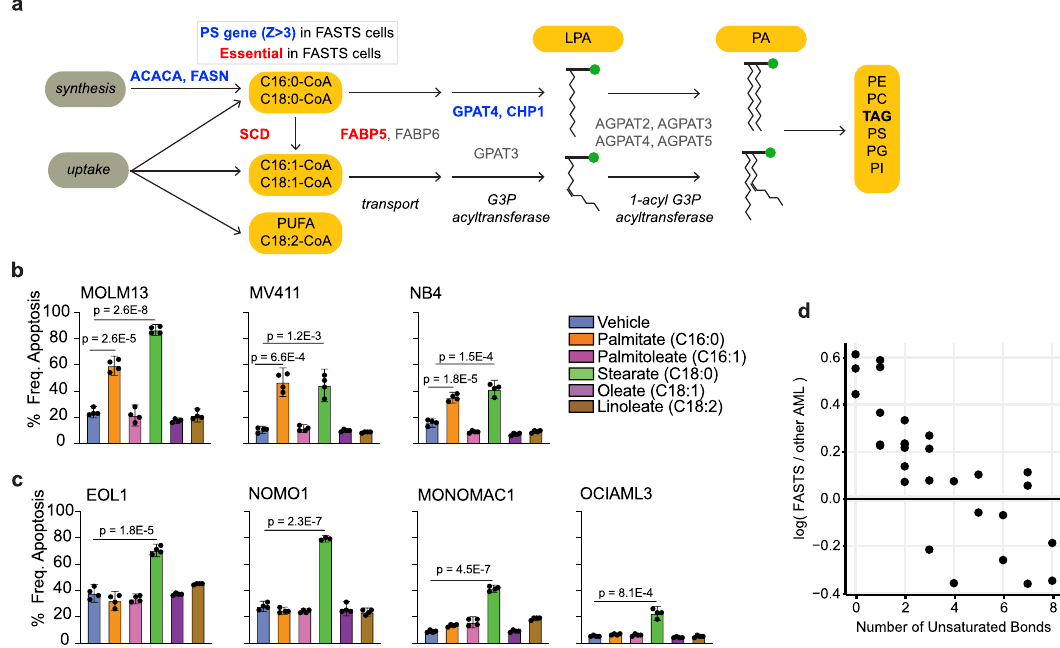
Fig. 5 FASTS cells are sensitive to saturated FA. a Schematic of the fatty acid/glycerolipid synthesis pathway. Blue, PSG in FASTS cells. Red, essential genes. Pathway analysis suggests saturated fatty acids are a critical node. b Apoptosis of FASTS cells in response to media supplemented with 200 µ M fatty acids. All three cell lines show marked sensitivity to palmitate. Plotted bars in ( b ) show mean and 95% con fi dence interval (CI) of apoptosis %. P values in ( b ) and ( c ) represent one-sided unpaired t test comparisons. Each bar plot demonstrates four replicate samples for each condition and cell line tested. Data for ( b ) and ( c ) can be found in the source data fi le. d Triacylglycerol (TAG) species metabolite differences. The x axis represents the median difference of log10 normalized peak area of the metabolite in FASTS cells vs. all other AML cells. The y axis represents the number of saturated bonds present. Each dot represents a unique